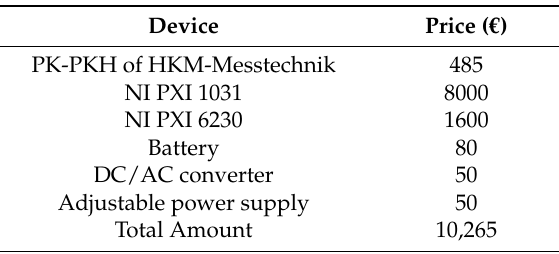
Table 5. Testbed cost.